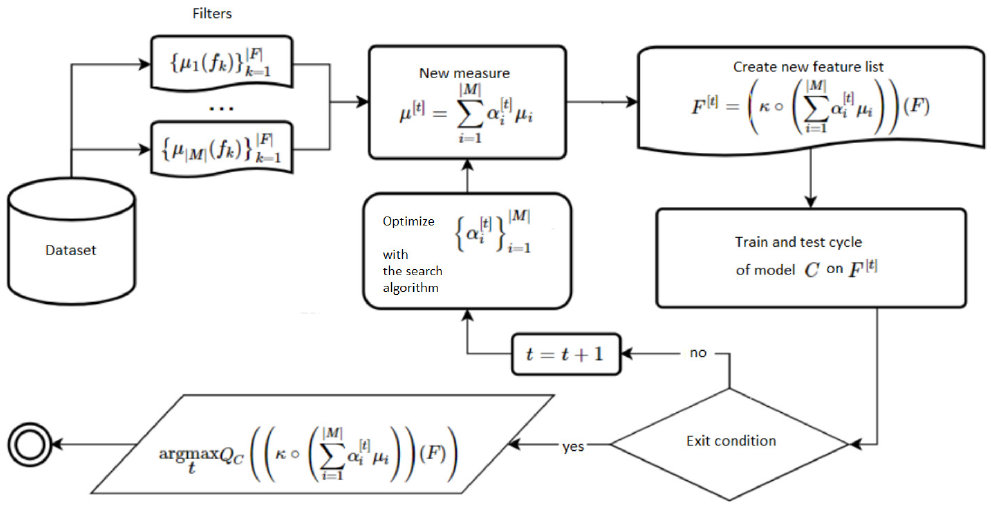
Figure 2. Hybrid algorithm MeLiF